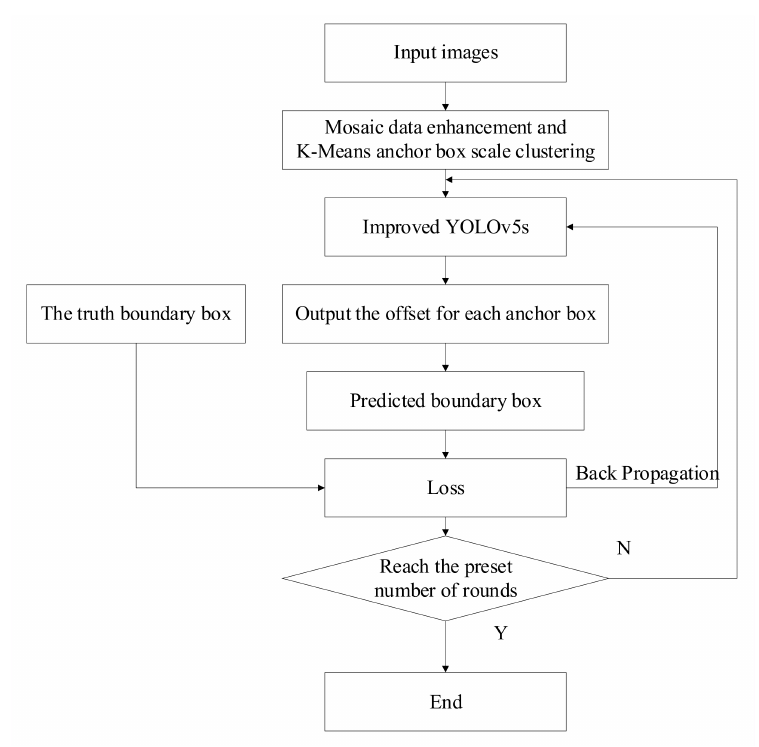
Figure 9. Training process of the Improved